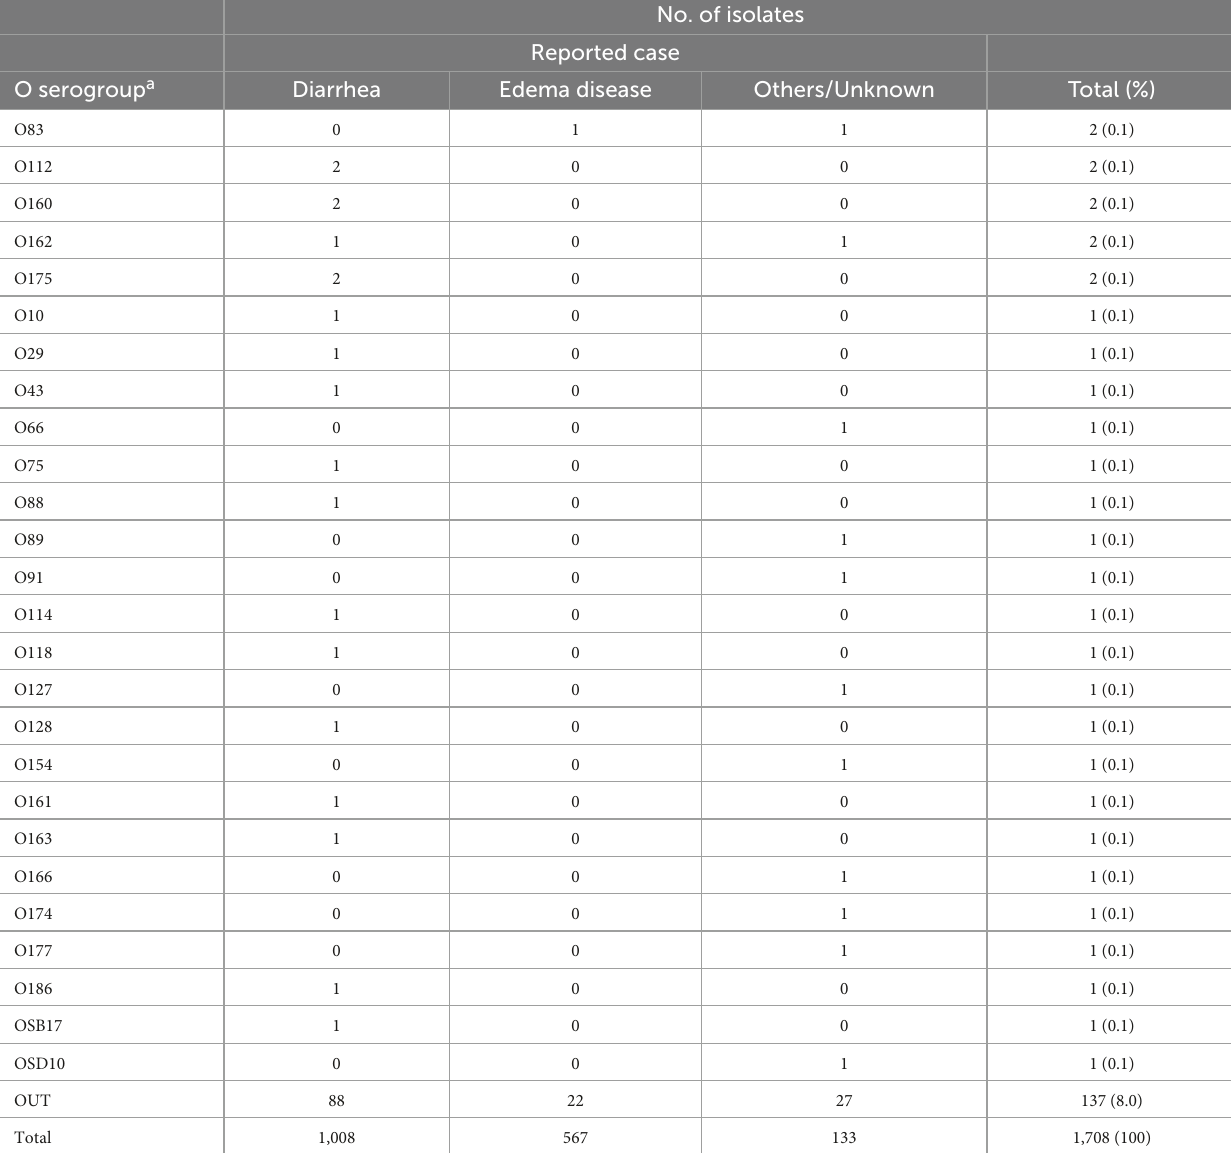
Supplementary Figure 2 for the statistical significance of the differences between O139, O149, O116, and OSB9) revealed that the resistance profiles of O139 and O149 are similar in general, but the O149 strains showed significantly higher resistance rates to seven antimicrobials (cefuroxime, cefotaxime, kanamycin, nalidixic acid, ciprofloxacin, levofloxacin, and gatifloxacin; P < 0.05) and lower rates to colistin ( P < 0.001). The profiles of O116 and OSB9 were also similar, but the O116 strains showed higher resistance rates to five antimicrobials (ampicillin, cefoxitin, ciprofloxacin, levofloxacin, and gatifloxacin; P < 0.05) and lower resistance rates to three antimicrobials (cefotaxime, gentamicin, and streptomycin; P < 0.05). Compared to both O139 and O149, O116 and OSB9 showed higher resistance rates to 11 antimicrobials ( P < 0.05): ampicillin, cefuroxime, cefoxitin, gentamicin, kanamycin, tetracycline, nalidixic acid, ciprofloxacin, levofloxacin, gatifloxacin, and trimethoprim-sulfamethoxazole